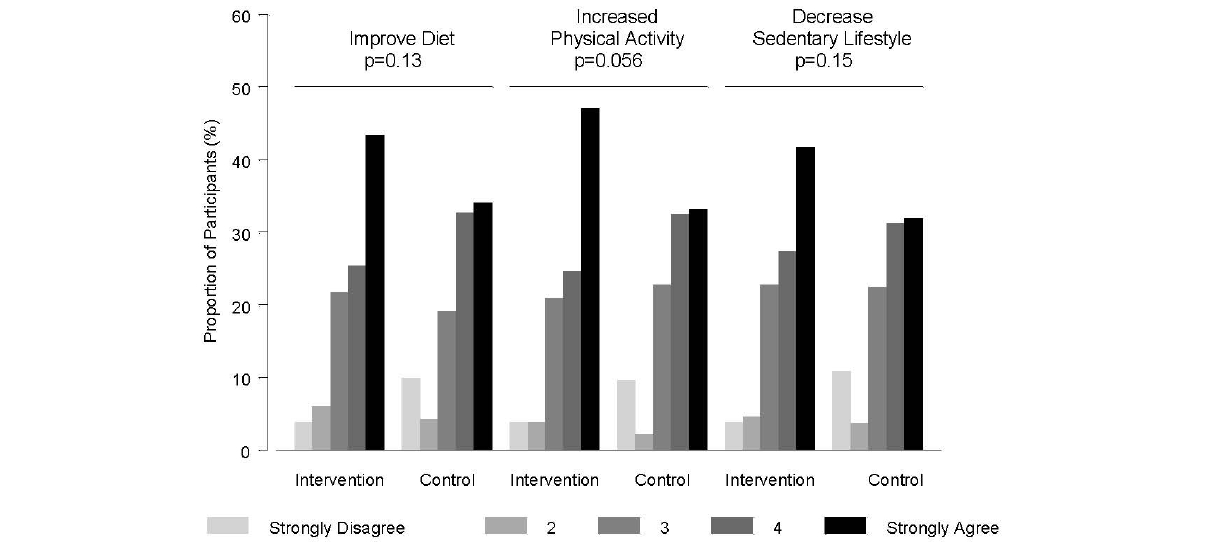
Figure 10. Motivation to change behavior based on risk score reports.